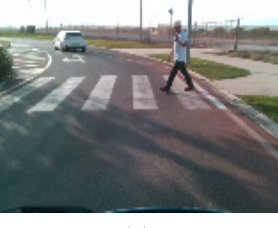
Figure 2. Images from dataset. ( a ) Pedestrian crossing; ( b ) saturation due to reflections on the road; ( c ) car braking; ( d ) complex shadows on the road.